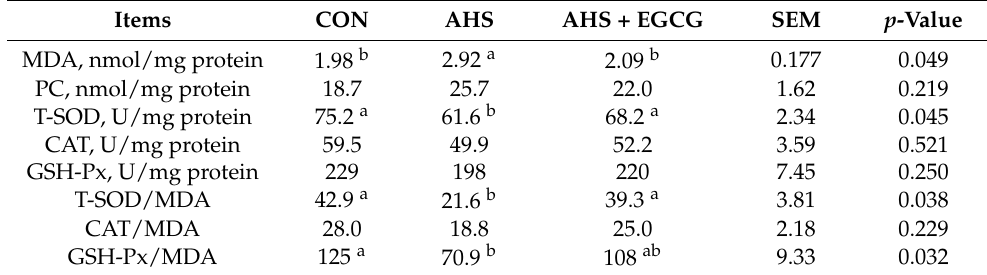
Table 5. Effect of EGCG on the muscle antioxidant capacity, MDA, and PC contents of broilers subjected to acute heat stress.